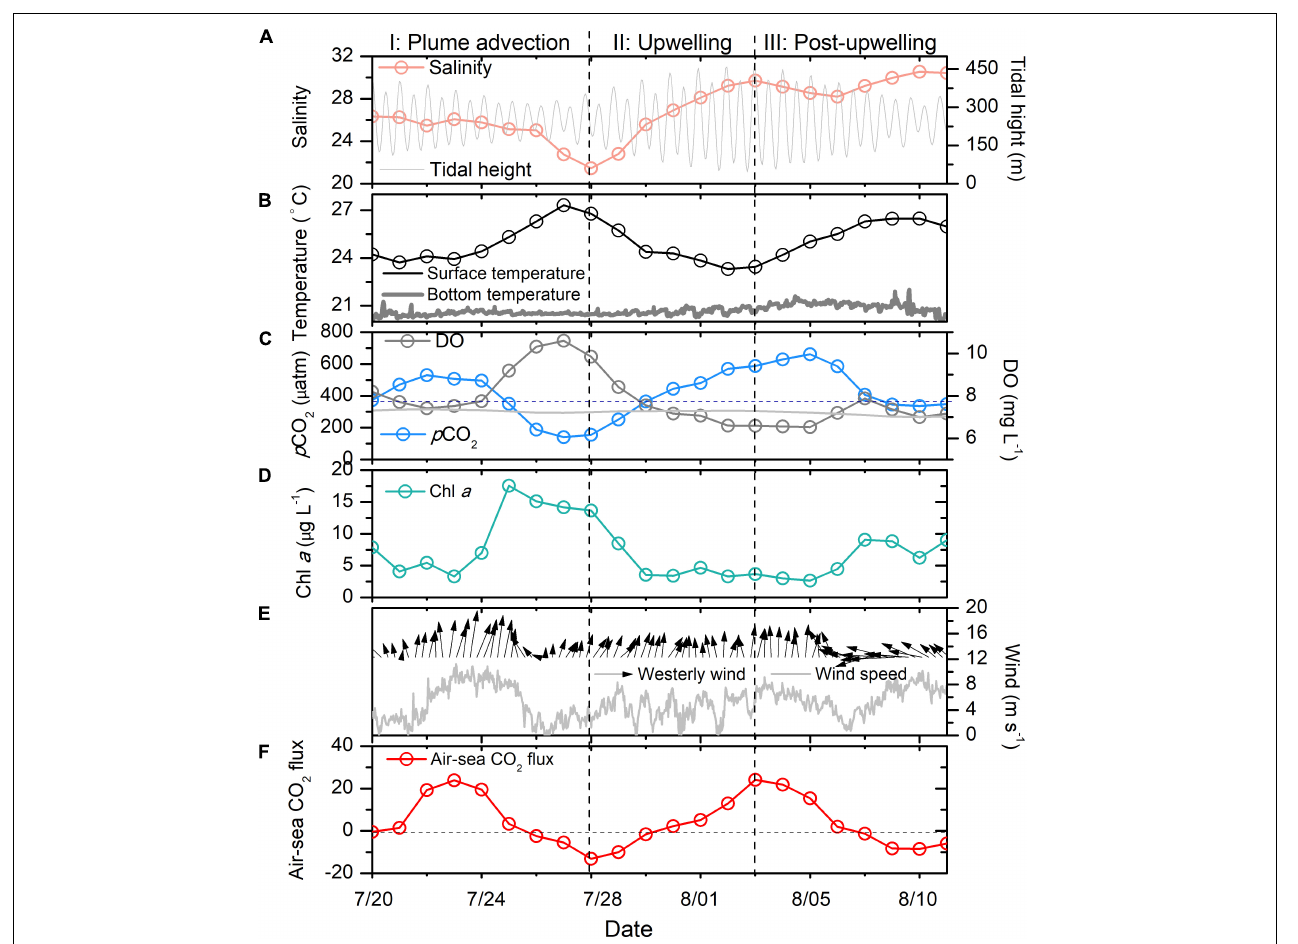
FIGURE 2 | Salinity (A) , temperature (B) , p CO 2 and DO (C) , Chl a (D) , wind (E) and air-sea CO 2 flux (F) variations during 20 July–11 August in the Changjiang plume waters. The gray dashed line in (C) is the atmospheric CO 2 , while the gray line is the saturated oxygen in surface waters. In (F) , the gray dashed line shows the position where the air-sea CO 2 flux is zero. The two vertical dashed lines indicate the dates used to divide our time series data into three